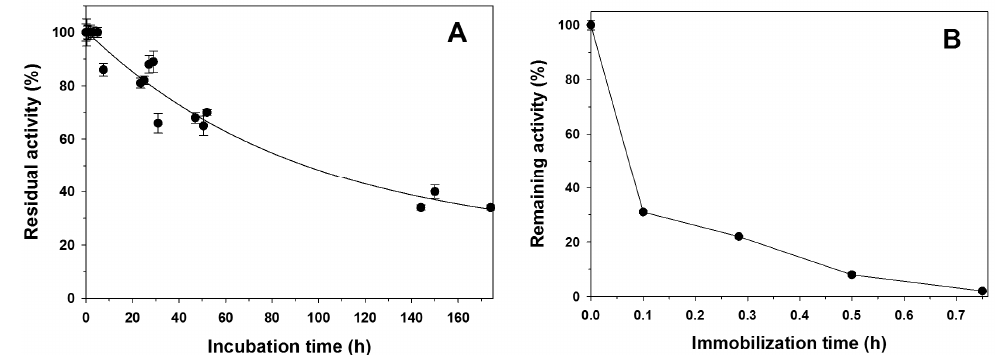
Figure 2. ( A ) Stability of soluble β‐ galactosidase from B. circulans in the coupling buffer (0.1 M sodium bicarbonate pH 10.0); ( B ) Progress of covalent immobilization of β‐ galactosidase from B. circulans on glyoxal agarose, monitored by measuring the residual activity in the supernatant.